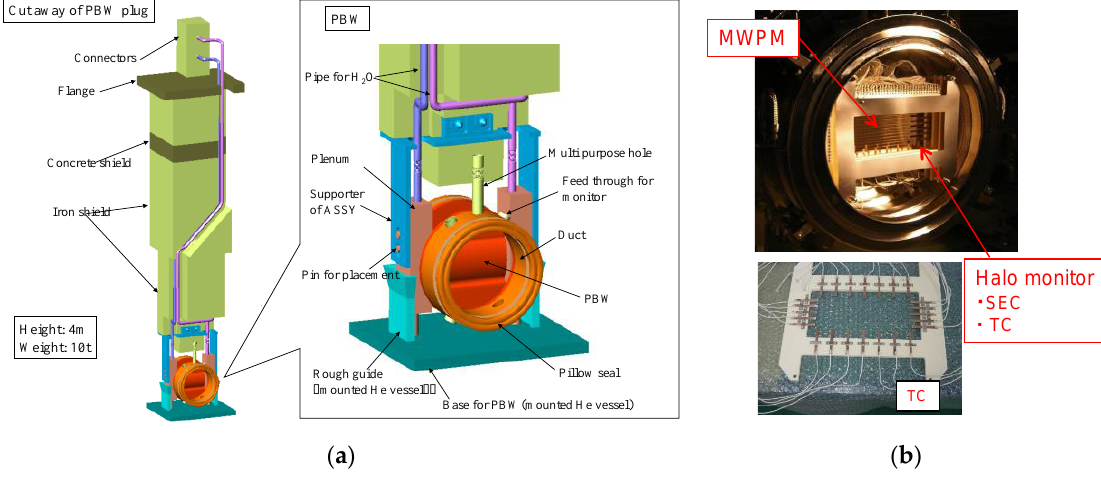
Figure 19. ( a ) Schematic drawing of proton beam window (PBW); ( b ) Beam monitor of MWPM and halo monitor consisting of a secondary electron emission counter (SEC) and thermo couples (TC) placed at the PBW.